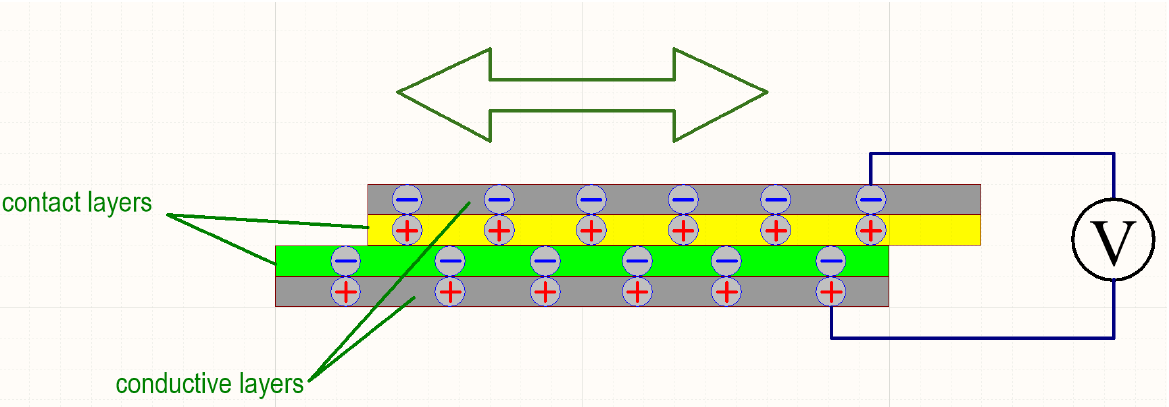
Figure 8. Principle of operation for triboelectric harvesters.